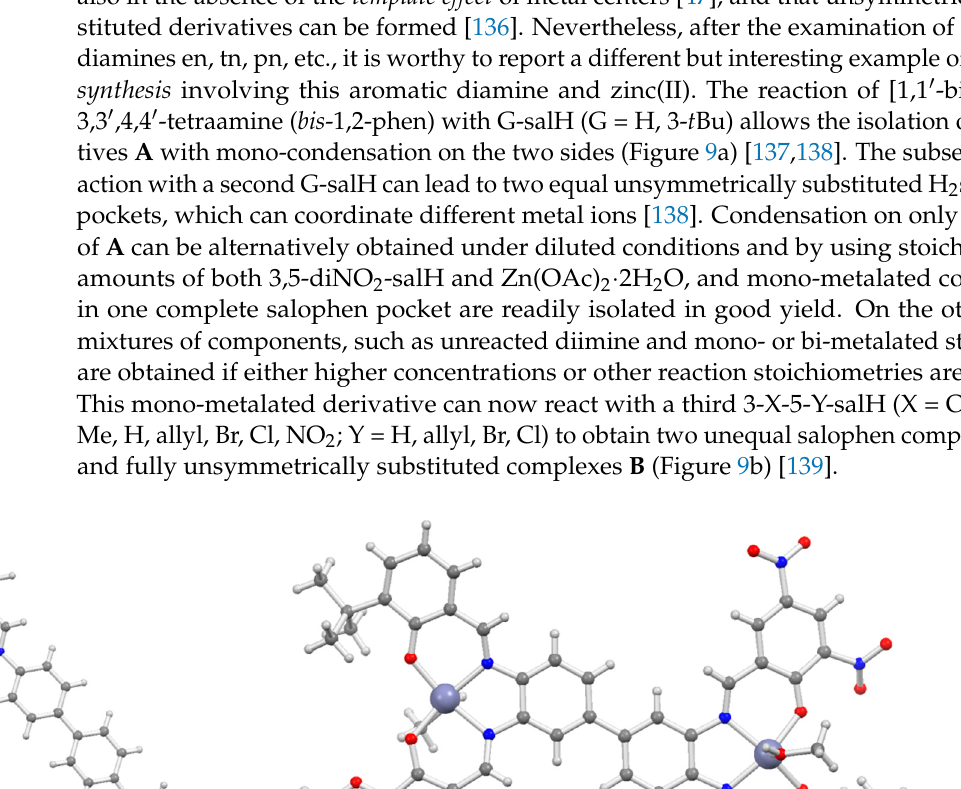
Figure 8. Molecular structures of ( a ) dinuclear [VO 2 ( H L)] 2 ( H L  from H-salH and pn), CSD/CCDC HAKROA/1171813 [134], and ( b ) [PPh 4 ] 2 [Mo(CN) 3 O( H L)]  5.5H 2 O ( H L  from H-salH and en), CSD/CCDC HEZZUH/113815 [135]. Reproduction of the structures with Mercury ® 4.3.1 software [71], color code: Mo = turquoise, V = light green, O = red, N = blue, C = gray, H = white or omitted, PPh 4+ cations and water molecules omitted for clarity.